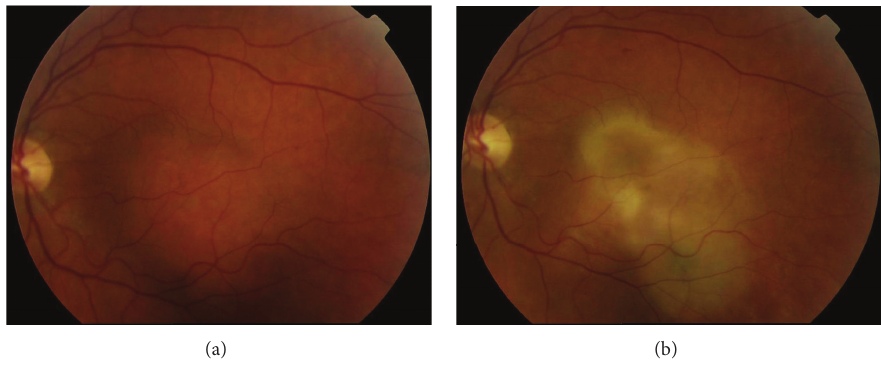
Figure 1: (a) Pale orange lesion involving the macula and extending inferotemporally before treatment. Clinical appearance is consistent with a circumscribed choroidal haemangioma. (b) After four months a pale, fibrotic scar has developed in the site of the original lesion following